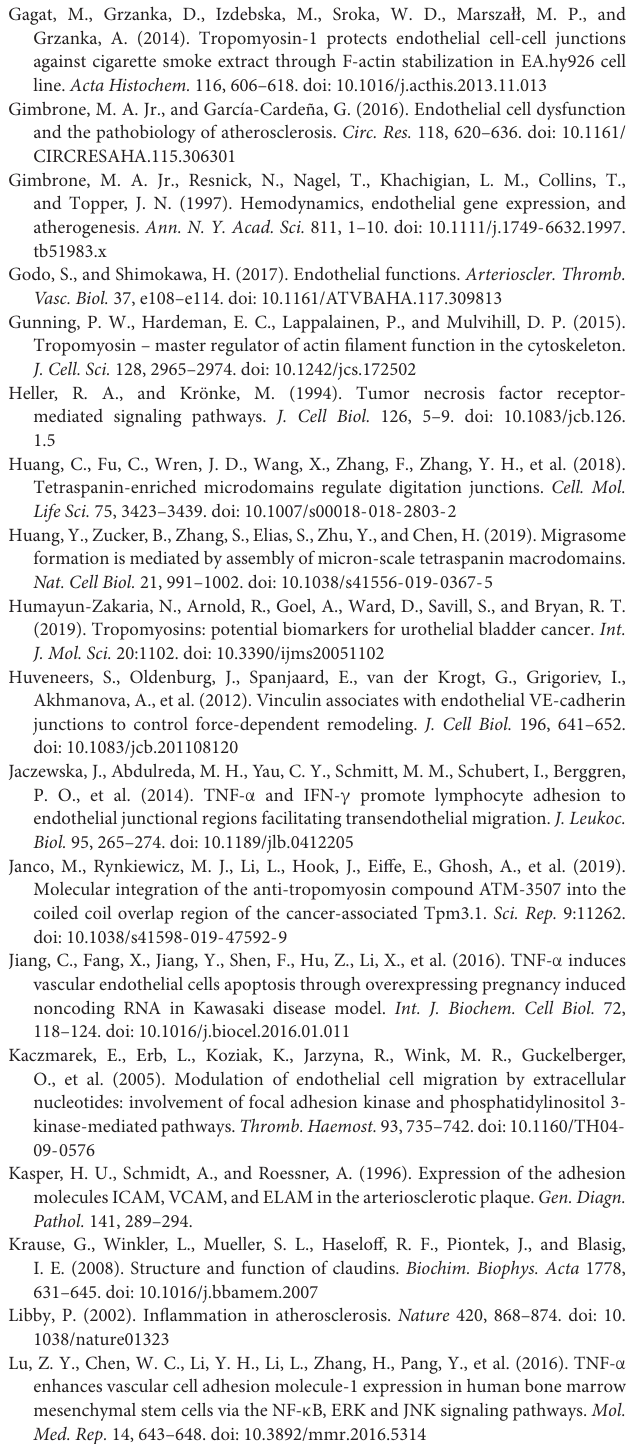
Supplementary Video S7 | Interactions of pHCAECs with migrasome released to cell culture medium. Actin-GFP (green) and talin-RFP (red) were expressed using baculovirus system. TNF α 100 ng/ml refers to cells treated with rh TNF α . Time-lapse images were acquired for 1.25 h at 5-min intervals after 18 h from treatment. Frame rate, 3